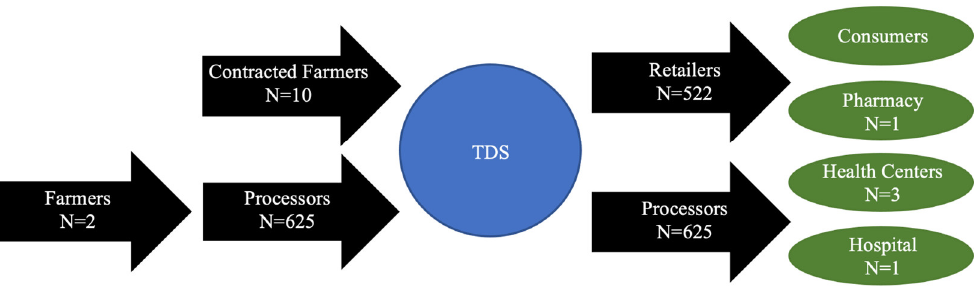
Figure 1. Instant Fortified Flour Value Chain.